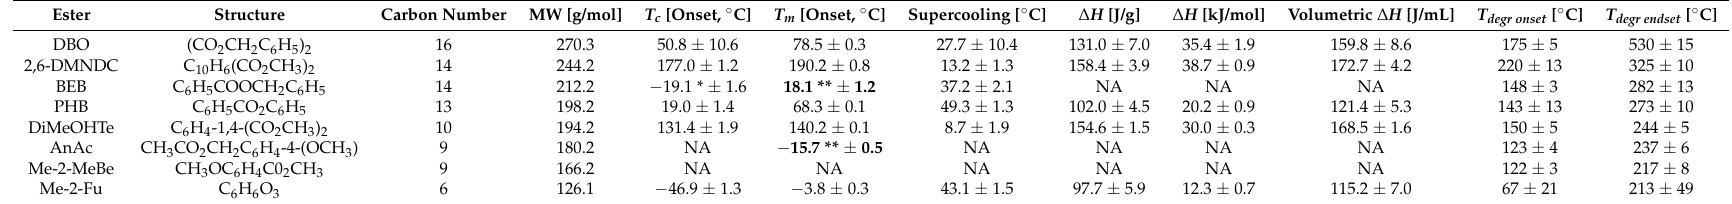
Table 2. Summary of thermal properties of the commercial aromatic esters investigated. T m and T c stand for the onset melting and crystallization temperature, respectively, ∆ H stands for the enthalpy of fusion, and T degr onset and T degr endset represent the starting and ending degradation temperatures. The molecular weight is abbreviated as MW (g/mol). The aromatic esters are ordered according to decreasing carbon number. The T m , T c and ∆ H values reported are the average value of three measurements for each compound conducted with six consecutive heating/cooling cycles at 10 and 2K/min, and are indicated alongside their standard deviations. In the case of experiments run with METTLER TOLEDO’s DSC with liquid nitrogen (AnAc, BEB, Me-2-MeBe), only one sample per compound was measured. The average calculated from these experiments is indicated in bold** and might not be fully representative of the compound’s properties. BEB was cycled both in a DSC equipped with liquid nitrogen and in a EasyMax cycling unit. The T c was calculated from the EasyMax experiment (*), while the T m from the DSC one (**). Missing data are indicated as Not Available (NA).